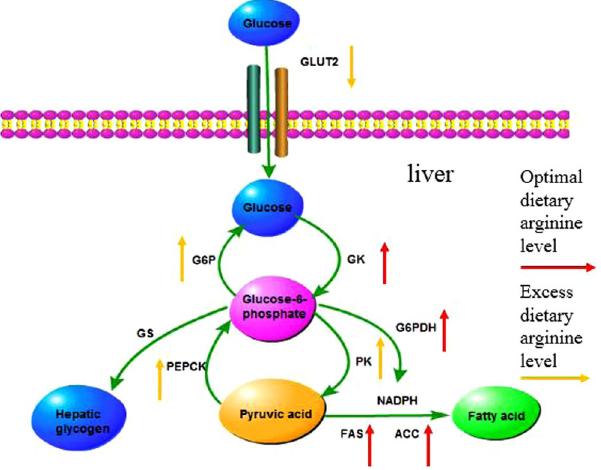
Figure 6. Glucose and lipid metabolism signaling pathway. Optimal dietary arginine level (1.62%) elevated the relative expression of Glucokinase (GK); Glucose-6-phosphate dehydrogenase (G6PDH); Fatty acid synthase (FAS); Acetyl CoA carboxylase (ACC). High dietary arginine level (2.70%) increased the relative gene expressions of Phosphoenolpyruvate carboxykinase (PEPCK); Glucose 6-phosphatase (G6P) and Pyruvate kinase (PK); lowered Glucose transporter 2 (GLUT 2).